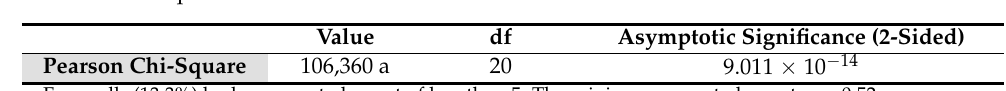
Table 17. Chi-square tests.